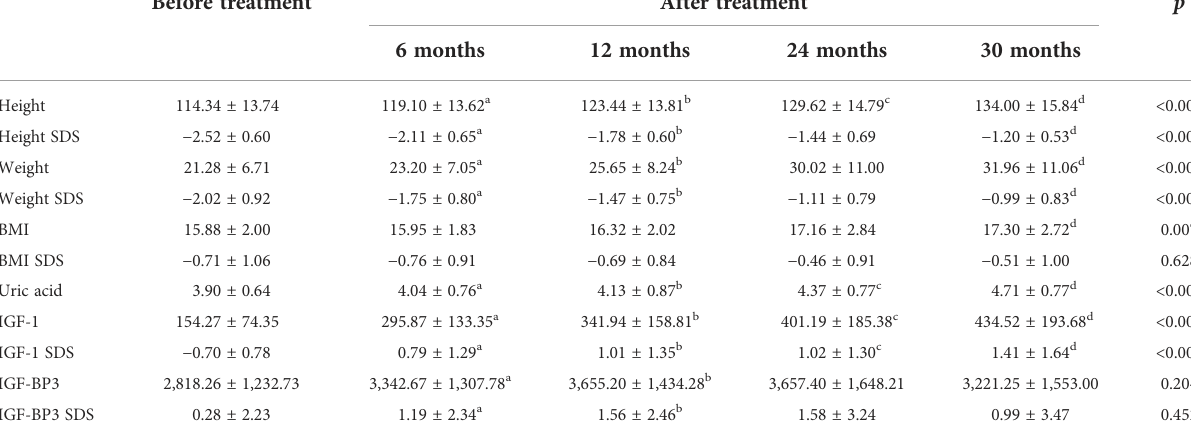
TABLE 4 Changes in anthropometric and biochemical variables during recombinant human growth hormone